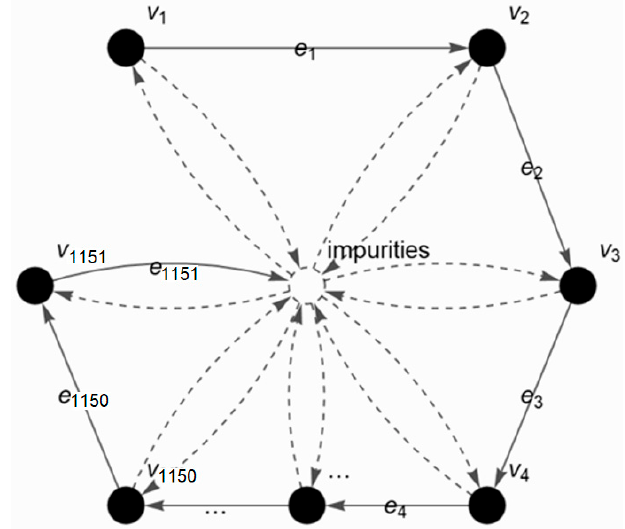
Figure 3. The FACS graph of RM100 banknote spectrum at 1800–650 cm − 1 wavenumbers region.